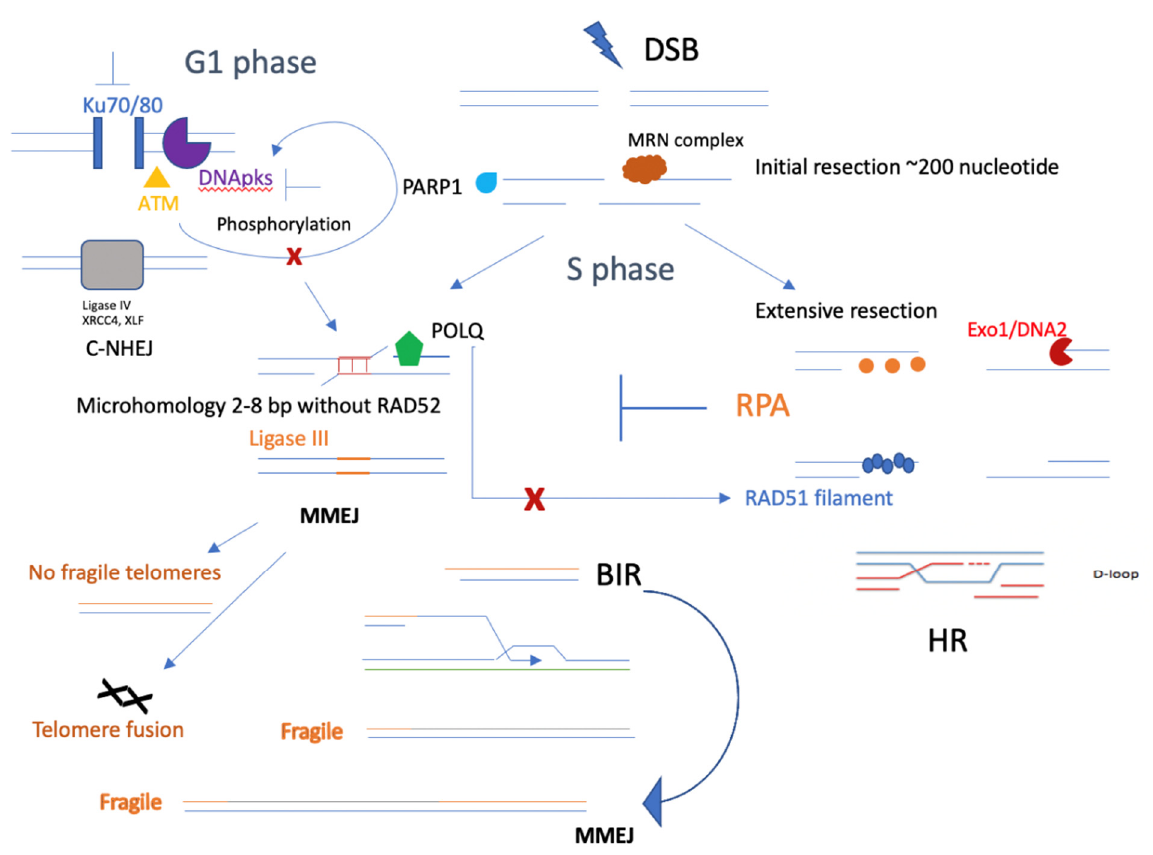
Figure 4. Competition between MMEJ and other DSB repair pathways. MMEJ, as an alternative nonhomologous end-joining pathway, competes with C-NHEJ, especially when the KU family is defective. It could also be possible that losing DNApk subunits or blocking ATM phosphorylation of DNApk would lead to defective C-NHEJ but elevated MMEJ. In the S phase of the cell cycle, initial resection will be the key step in promoting both HR and MMEJ, and the synthetic lethal relationship between HR and MMEJ could mainly occur in the S phase. In addition, several important factors, such as PARP1, may contribute to initial resection and promote MMEJ, and POLQ could functionally inhibit RAD51 [37] filaments, leading to less HR. In telomeres, MMEJ helps to repair most DSBs and does not generate fragile telomeres; however, it does cause telomere fusion. Instead, BIR would form fragile telomeres, which could be repaired better by MMEJ factors, such as PARP1 and ligase III.